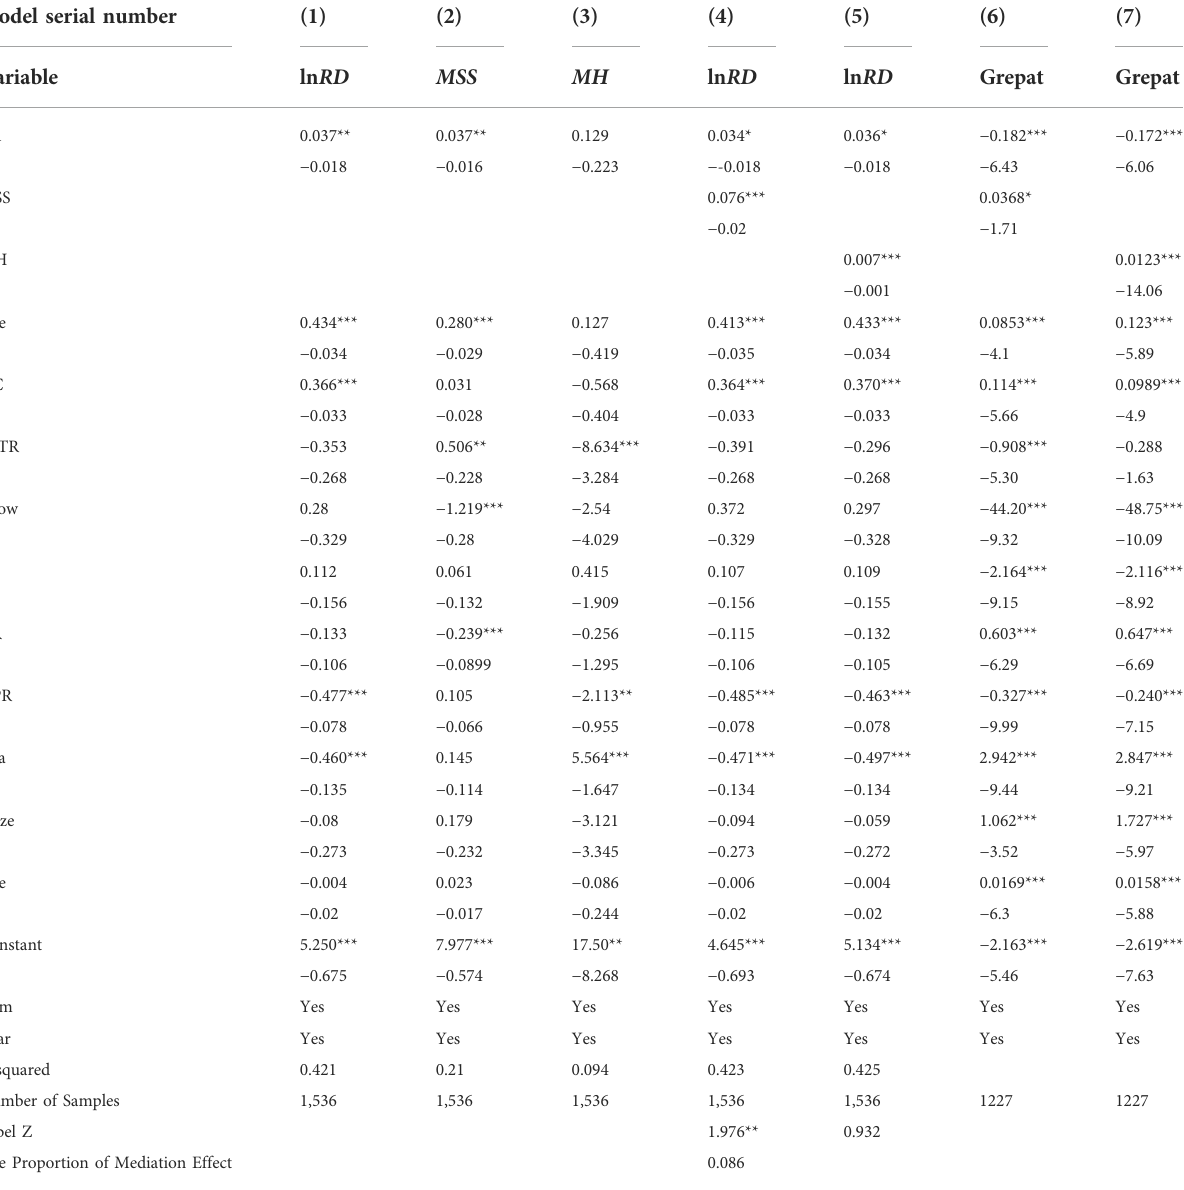
TABLE 3 Regression analysis and sobel